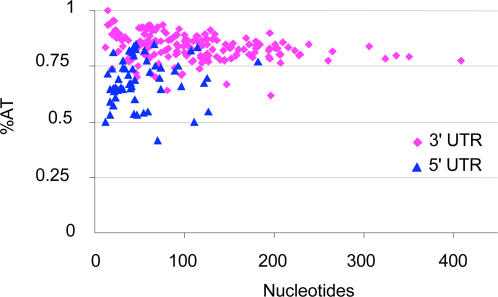
Distribution of UTRs by Length and %AT